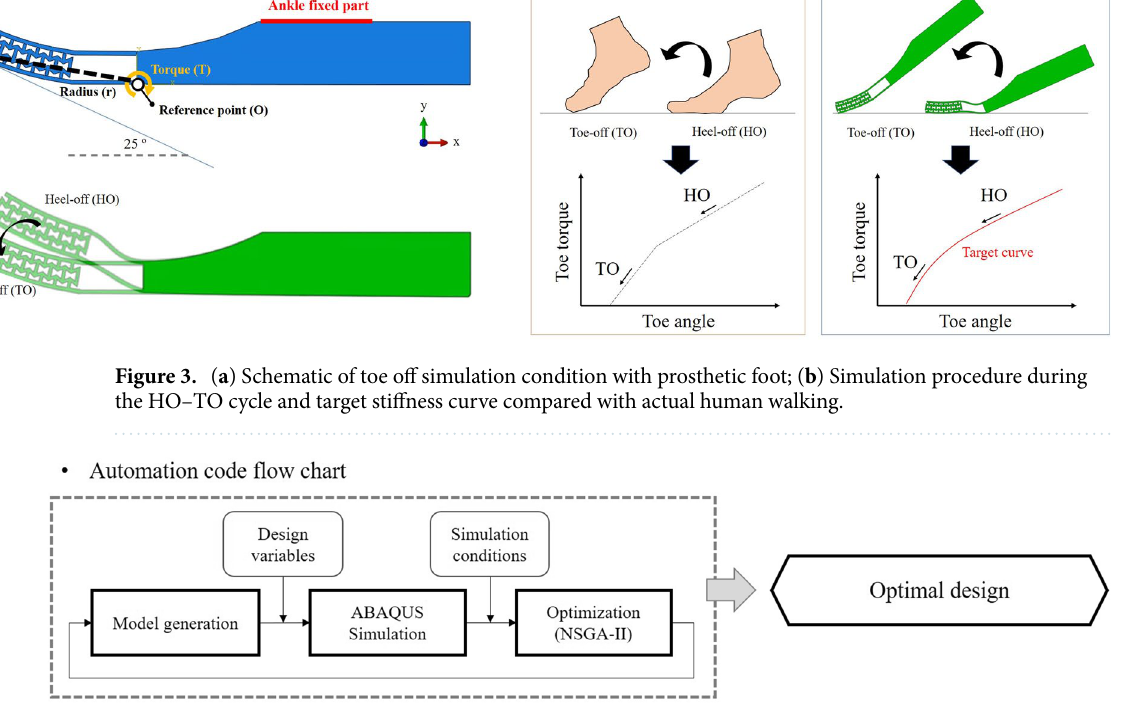
Figure 4. The flow chart of multi-objective optimization problem to design the prosthetic foot with optimal stiffness and maximum